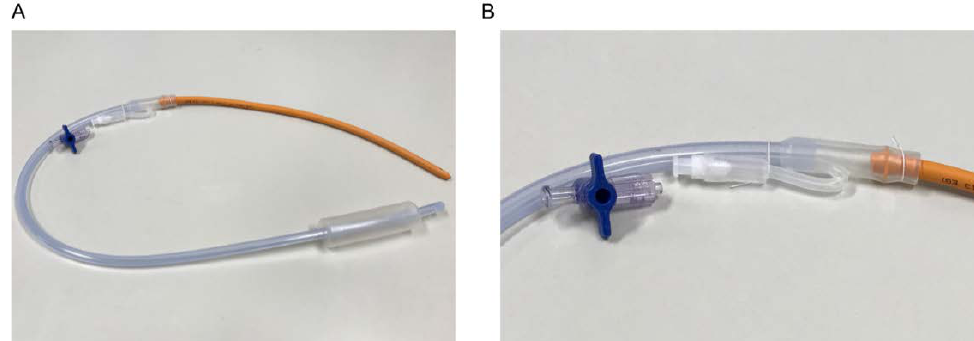
Figure 7. Preparation of the modified Matsubara Nelaton catheter. Reproduced from Taiwan J Obstet Gynecol. 2019;58:721-722. Matsuzaki S et al. Letter to “Cervical varices unrelated to placenta previa as an unusual cause of antepartum hemorrhage: A case report and literature review.” Successful management of postpartum hemorrhage due to cervical varix: modified Matsubara-Nelaton method using Bakri balloon/ Figure 1, Transvaginal sonography and speculum examination results., Copyright (2019) with permission from Elsevier [111]. ( A , B ) A Nelaton rubber tube is connected to perform the modified Matsubara Nelaton method as previously described [110–113]. However, we modified the Nelaton rubber tube type and its connections used from that of the original method. A No. 13 Nelaton rubber tube was attached to the blood drainage port of the Bakri